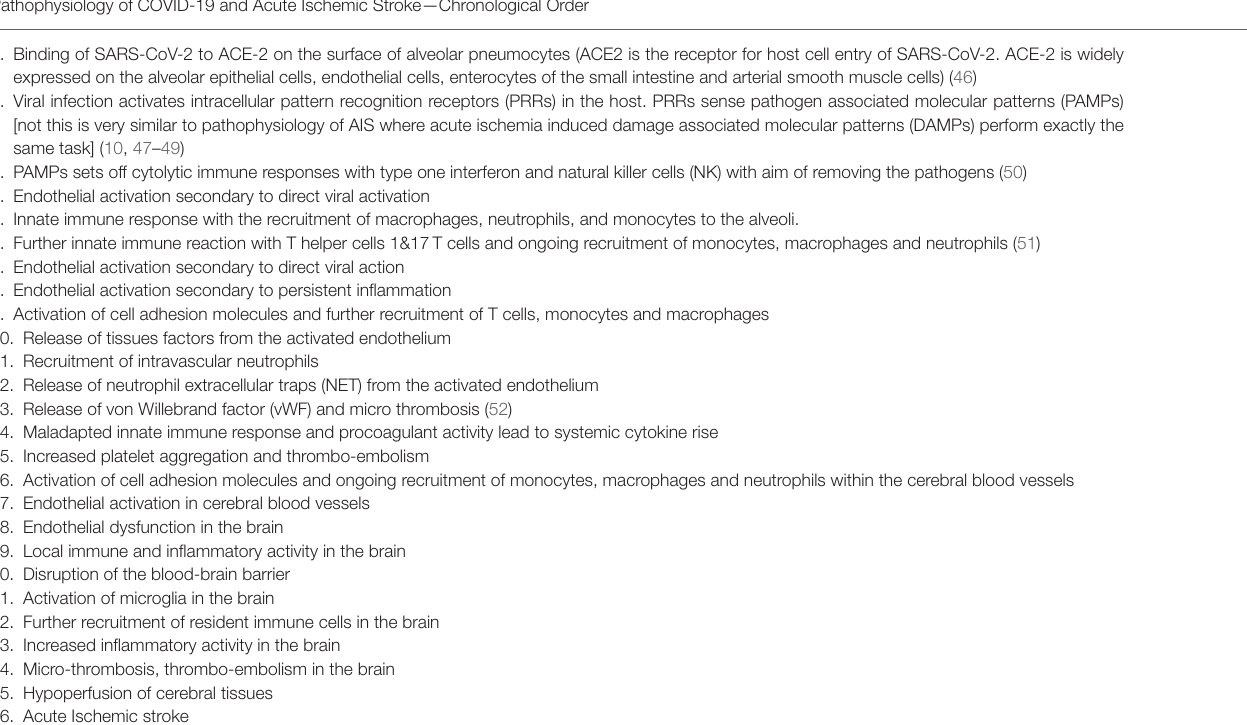
TABLE 2 | Pathophysiology of COVID-19 and acute ischemic stroke. Pathophysiology of COVID-19 and Acute Ischemic Stroke—Chronological